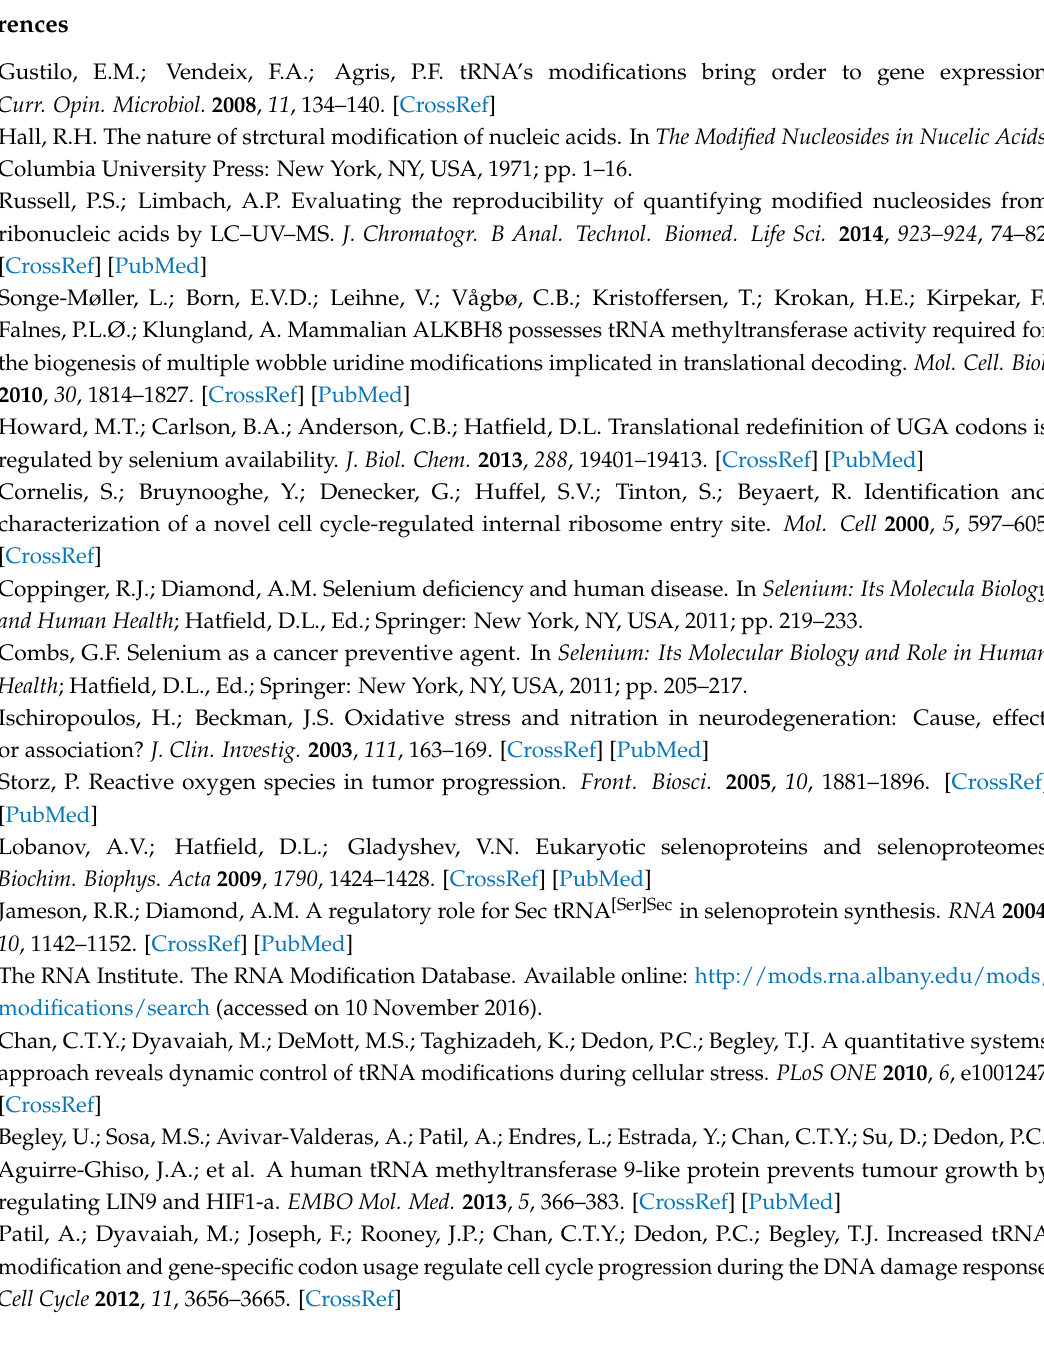
Figure S1: Average current profiles of empty pores derived from 10 ns trajectories, Figure S2: Average current profiles of single canonical nucleosides derived from 40 ns trajectories in 1.5 nm pore, Figure S3: Average current profiles of single modified and unmodified uridines derived from 40 ns trajectories in 1.5 nm